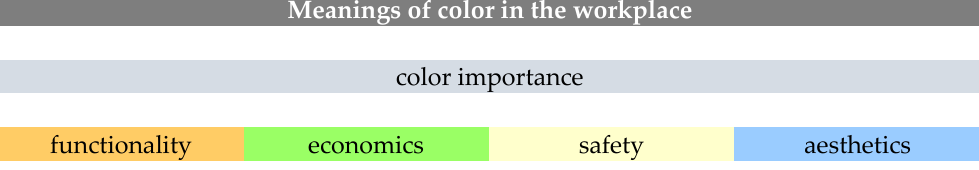
Figure 1. The importance of colors in the workplace.